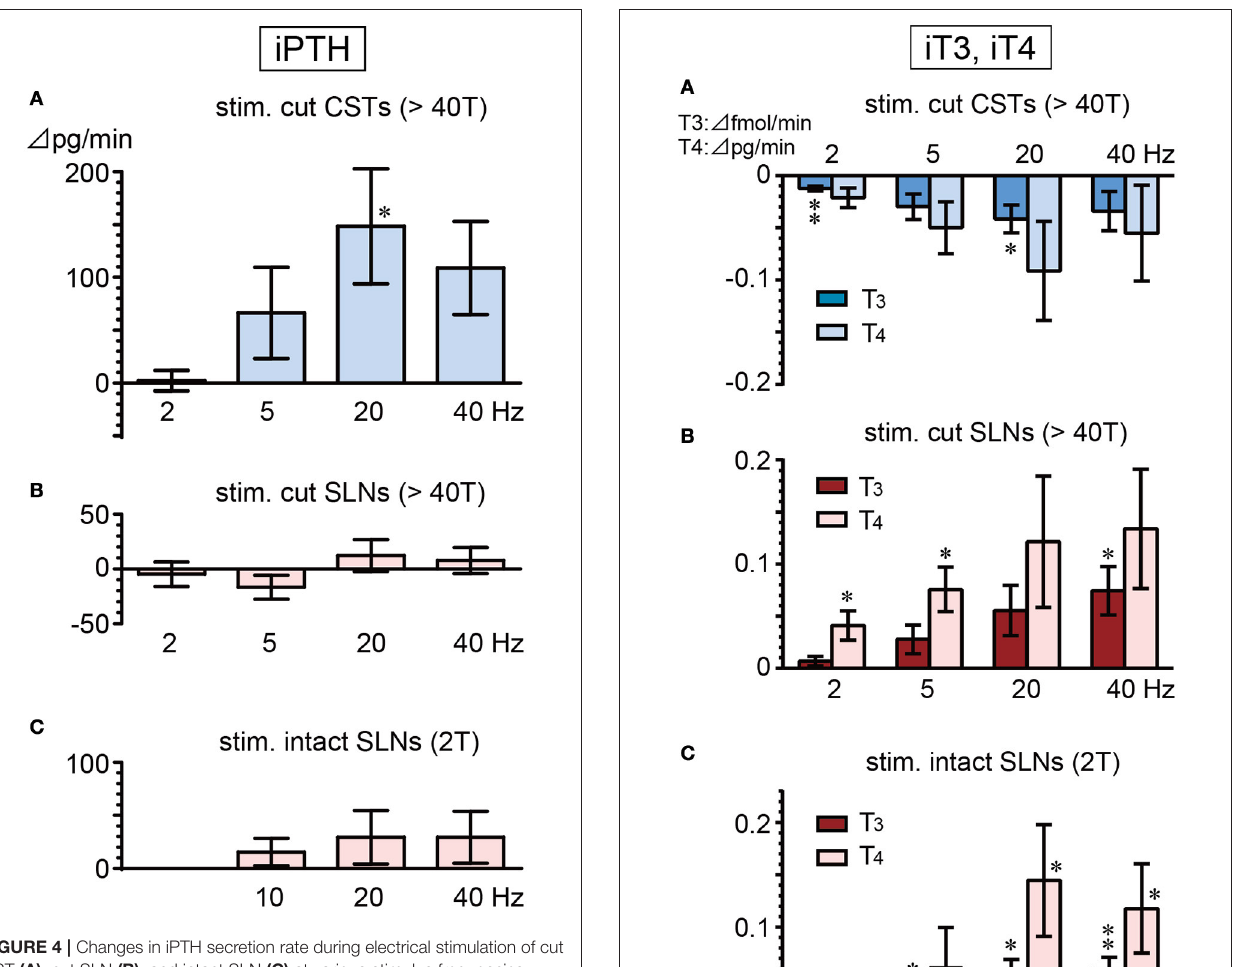
iCT at 40 Hz contrasted with the significant increase in